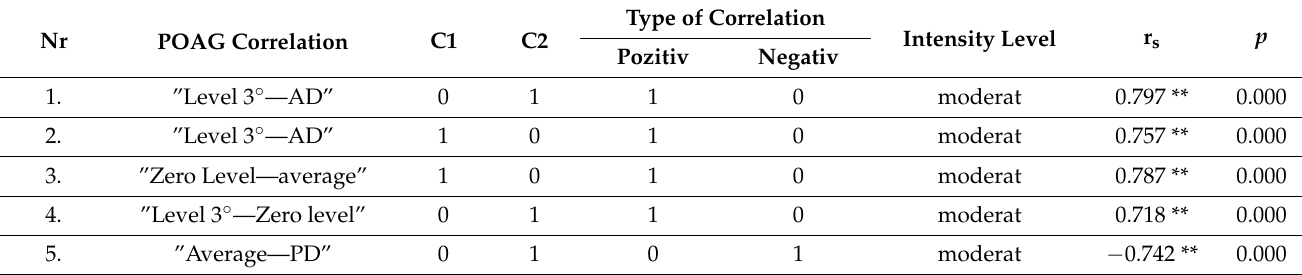
Table 9. Distribution of moderate-intensity correlations between “Visual Field” parameters in patients with POAG, at the first consultation (C1) and at the last consultation